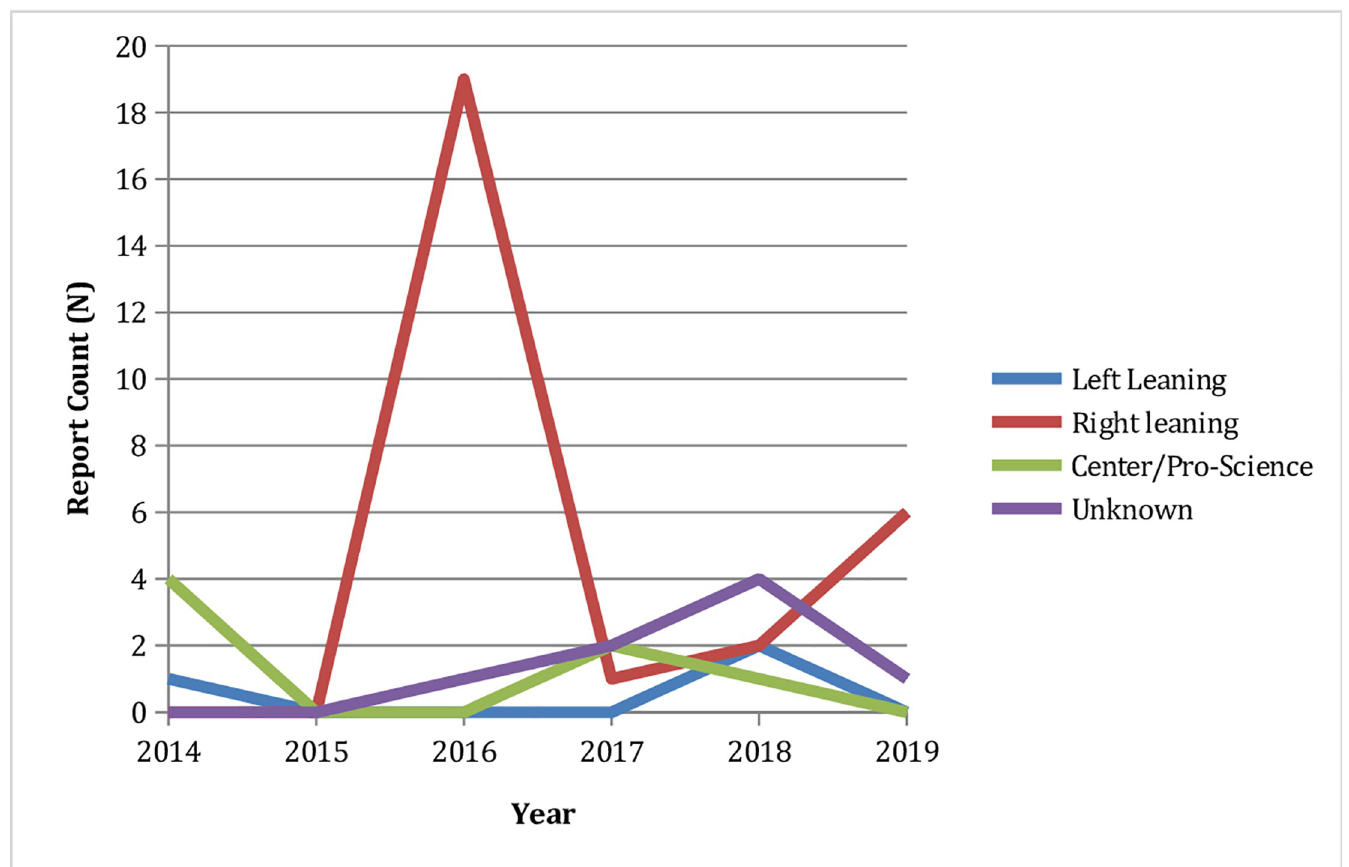
Fig 3. TB report count categorized by political leaning by year.